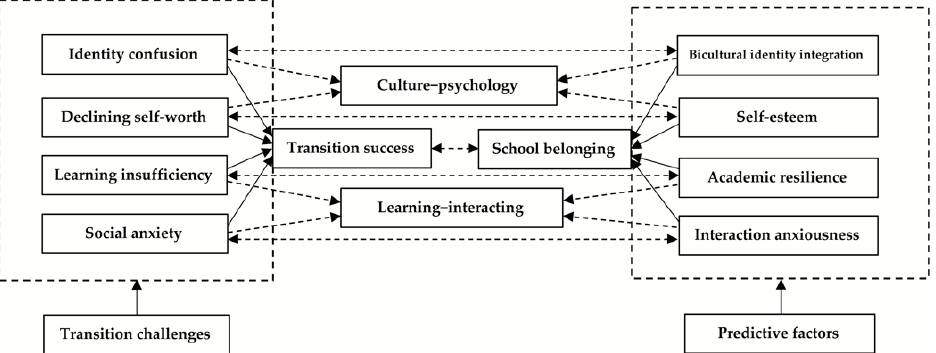
Figure 1. Conceptual model. The solid right icon arrow means the influence of summarized transition challenges on transition success. The solid left icon arrow implies the impact of extracted key factors on school belonging. The single dashed arrow points to the categorized dimension. The double dashed arrow indicates the inter-relationship between observed variables and transition chal- lenges.